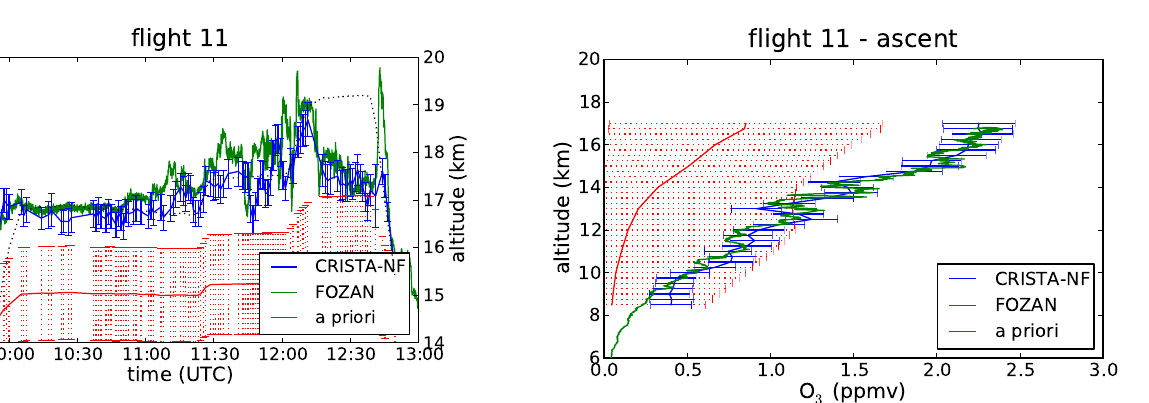
Fig. 12. Comparison of ozone mixing ratios as measured by Fig.12. ComparisonofozonemixingratiosasmeasuredbyFOZANandderivedbyCRISTA-NF.Shown Fig. 13. Comparison of ozone mixing ratios as measured by FOZAN and derived by CRISTA-NF. Shown in blue are CRISTA- Fig. 13. Comparison of ozone mixing ratios as measured by FOZAN and derived by CRISTA-NF. in blue are CRISTA-NF results including error bars showing the “total+smooth” error. Shown in green FOZAN and derived by CRISTA-NF. FOZAN measurements are FOZAN measurements are taken from the ascent of the plane from 09:34 to 10:04 (UTC) while the NF results including error bars showing the “total+smooth” error. are FOZAN measurements. Shown in red is the a priori. The dotted line indicates the plane altitude at taken from the ascent of the plane from 09:34 to 10:04UTC while CRISTA-NF profile is assembled from several retrieved profiles taken between 10:55 and 11:20 (UTC) measurement time with scale on the right. Shown in green are FOZAN measurements. Shown in red is the a that measure roughly the same air mass. the CRISTA-NF profile is assembled from several retrieved profiles priori. The dotted line indicates the plane altitude at measurement taken between 10:55 and 11:20UTC that measure roughly the same time with scale on the right. air